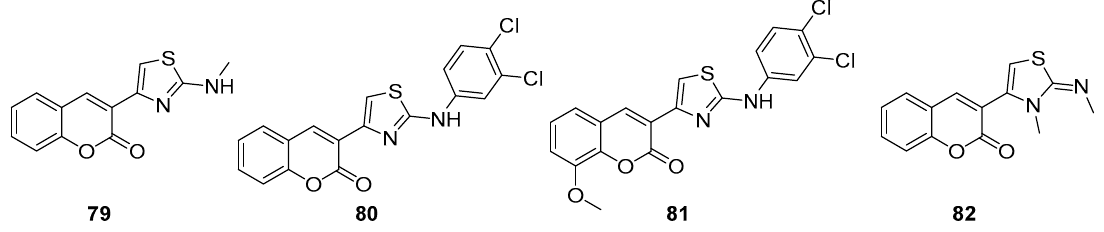
Figure 30. Hybrid pharmacophores proposed by Osman and co-workers [125].